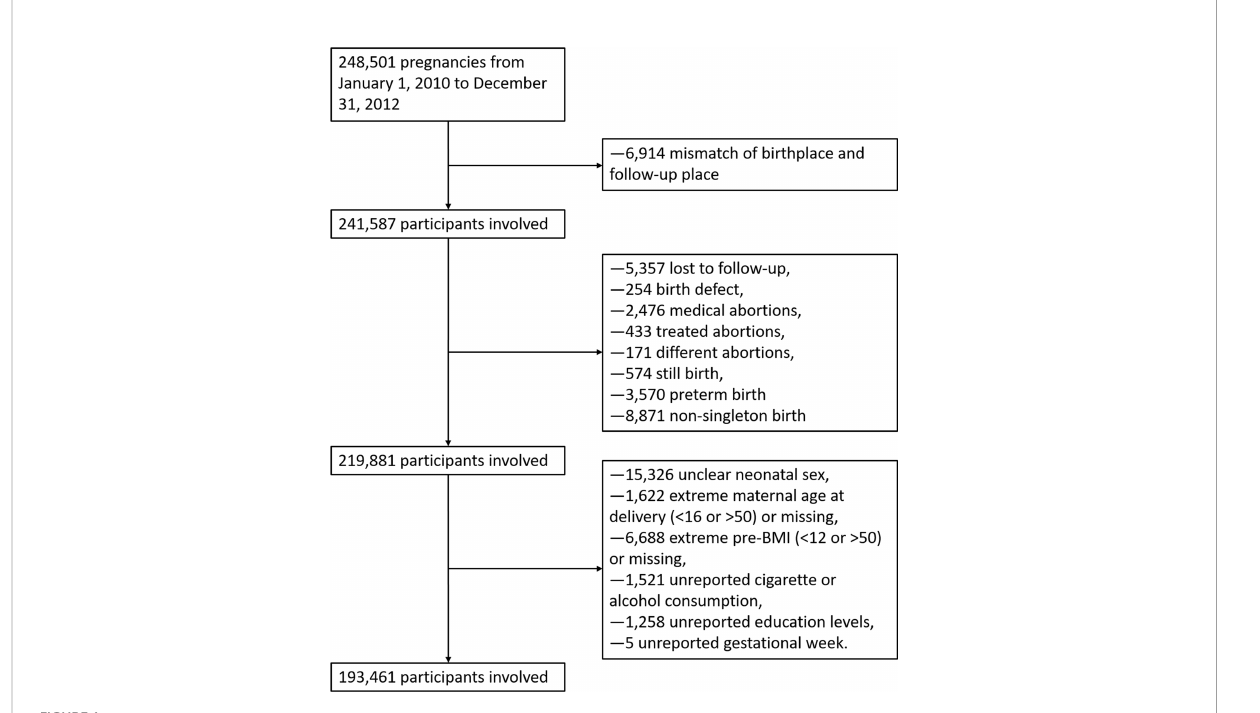
FIGURE 1 Flowchart of inclusion and